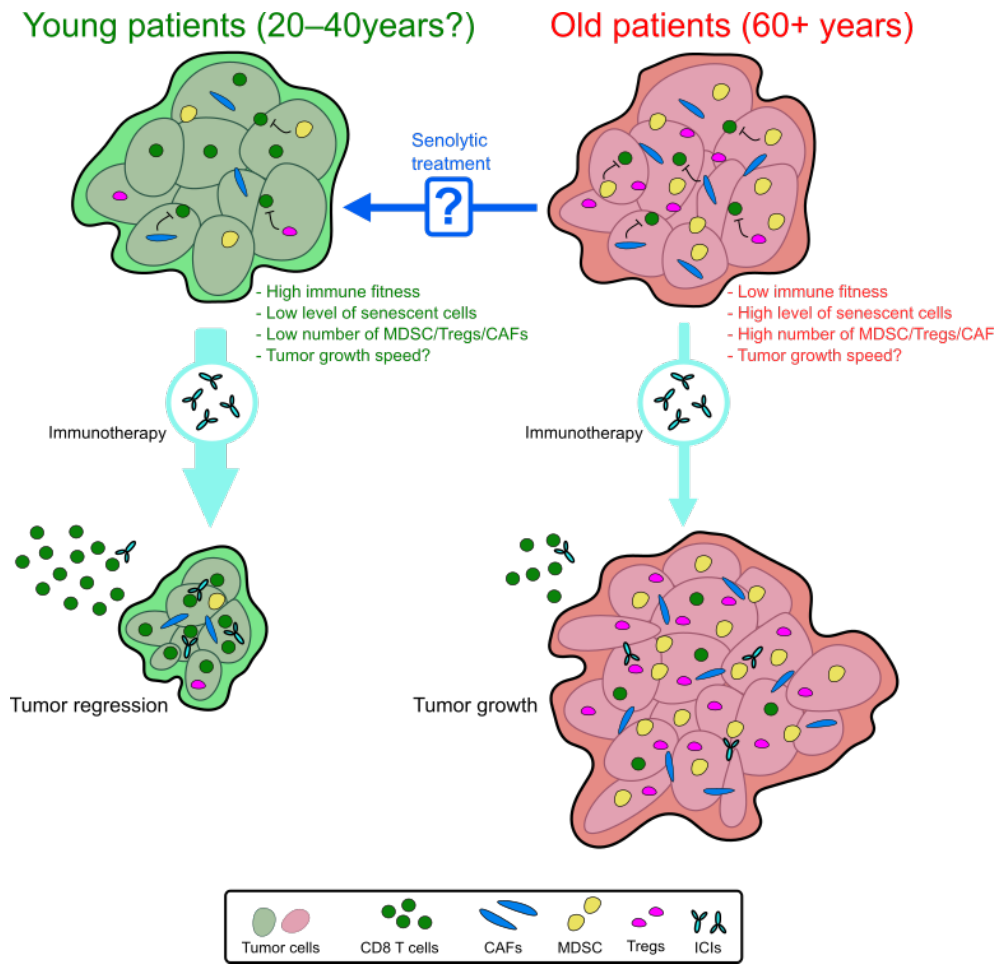
Figure 1. Predictive model of the immunotherapy efficacy in young and old patients. In old patients, we expected a loss of immunotherapy efficacy. Within the TME, the decrease in immune cell fitness with the enrichment of senescent cells and immunosuppressive cells (MDSC, Tregs, and CAFs) can be responsible for this resistance. Pretreatment with a senolytic drug could reverse this immunosuppressive context and enhance the immunotherapy efficacy in aged patients.